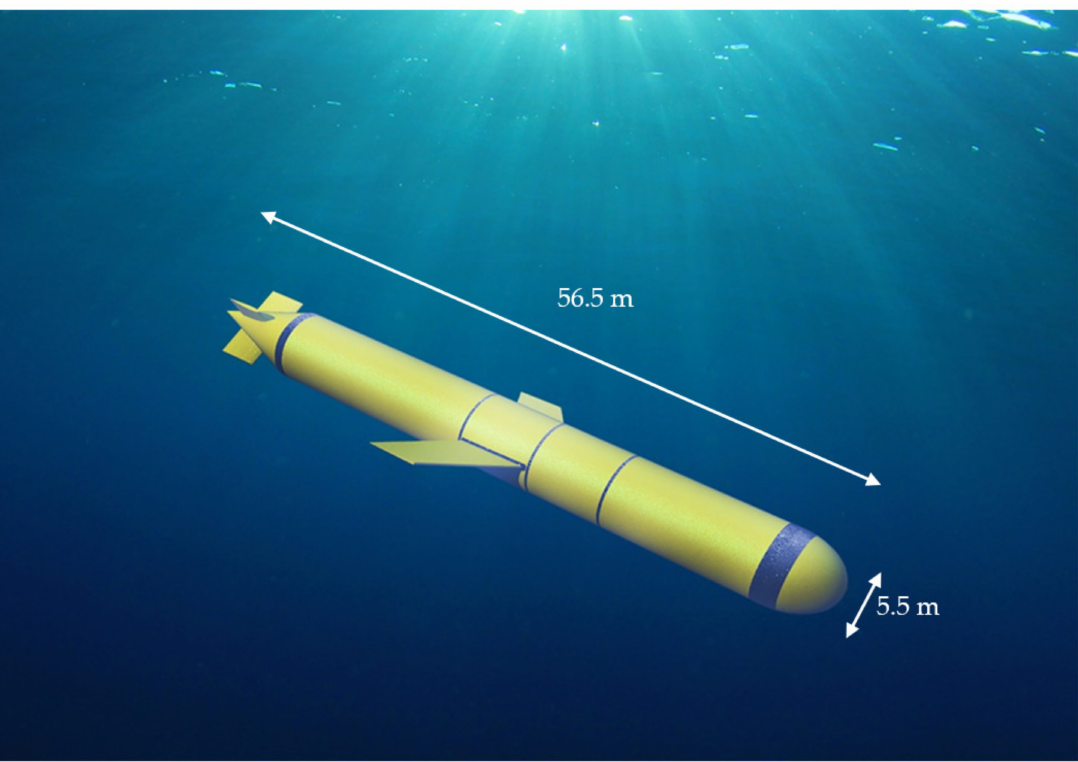
Figure 1. Design of the subsea freight